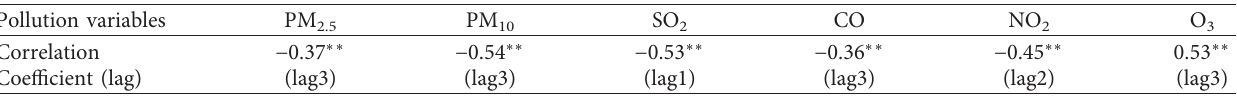
Table 5: The highest associated time lags and maximum correlation coefficients TB incidence to each pollution variable.